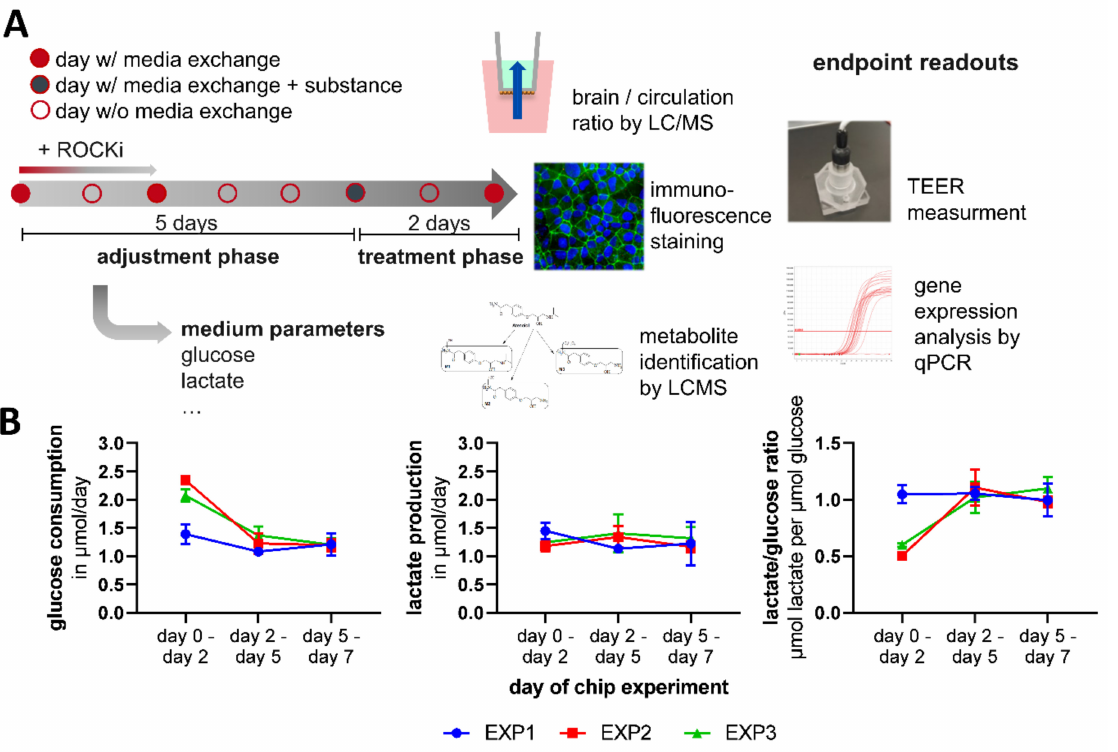
Figure 2. Cultivation schedule and medium parameters of the one-week coculture. ( A ) Schematic of the dynamic coculture in the HUMIMIC Chip4, with in-process measurement of medium parameters and end-point analysis. Organ models are cultured for 7 days in total in the Chip4, with a 5-day adjustment phase and a 2-day treatment phase. Medium is exchanged every 2–3 days. At the end of the assay, different endpoint readouts such as the measurement of substance concentration by LC/MS, TEER measurement, immunofluorescence staining, metabolite identification by LCMS and gene expression analysis are performed. ( B ) Glucose consumption, lactate production and lactate/glucose ratio from three experiments (N = 3). Mean values + s.e.m. per experiment with 3